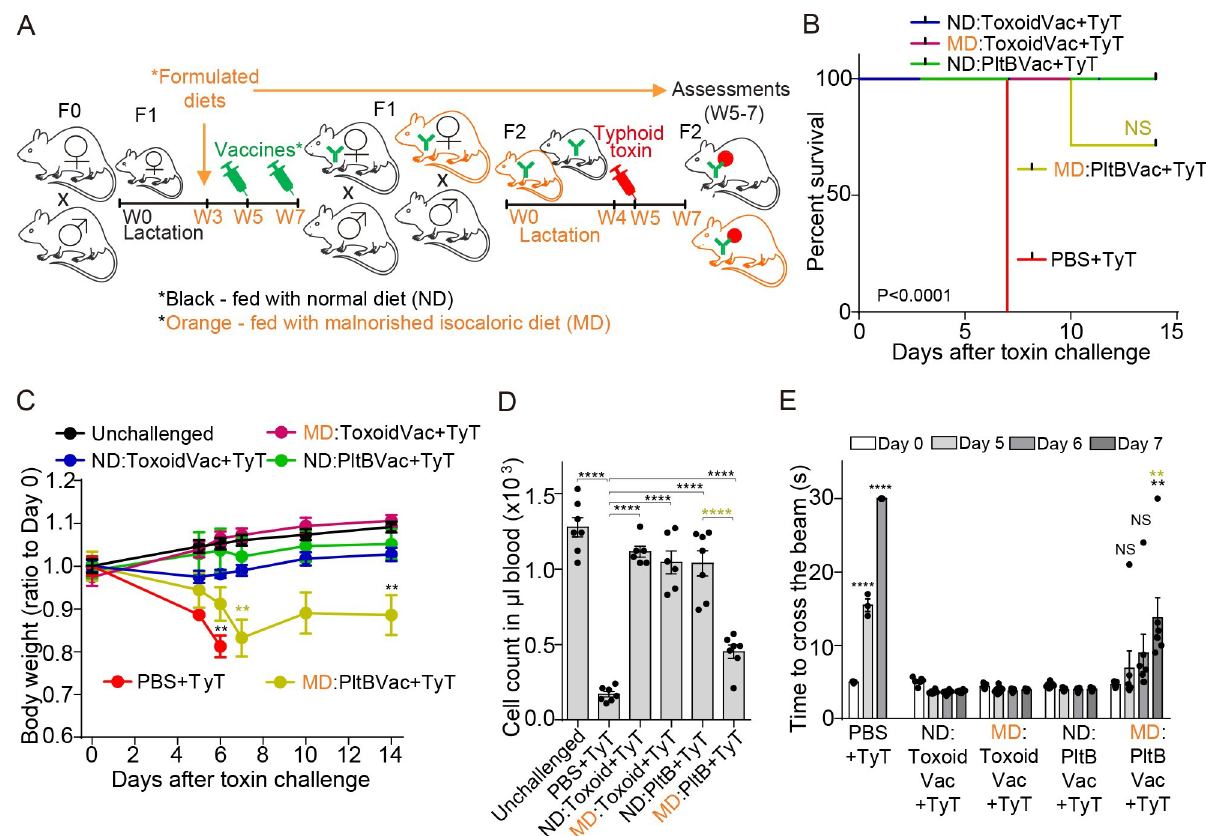
Fig 3. Maternal antibodies protected some but not all progenies against typhoid toxin in malnutrition. A , Timelines of indicated diet-feeding, maternal vaccinations, toxin challenge, and assessments for protection. Both F1 and F2 mice were fed with indicated diets, which were started when F1 mice were 3 weeks old and continued throughout the experimental timeframe. B , Survival of the maternally-vaccinated F2 mice challenged with 2 μ g typhoid toxin (TyT). ND:ToxoidVac (blue), normal diet-fed F2 mice maternally vaccinated with ToxoidVac. MD:ToxoidVac (plum), malnourished diet-fed F2 mice maternally vaccinated with ToxoidVac. ND:PltBVac (green), normal diet-fed F2 mice maternally vaccinated with PltBVac. MD: PltBVac (olive), malnourished diet-fed F2 mice maternally vaccinated with PltBVac. C , Body weight changes of these F2 mice after receiving 2 μ g typhoid toxin for the 14 day-experimental period. D , Circulating neutrophil counts in peripheral blood of these F2 mice on day 6 after the toxin challenge. E , Balance beam walking results of these F2 mice on days 0, 5, 6, and 7 after the toxin challenge. Bars represent the mean ± SEM. n = 6–7 F2 mice per group. NS, not significant; �� , p < 0.01; ���� , p < 0.0001, relative to the unchallenged group for C, to the unchallenged group or the TyT group for D as indicated in the graph, and to the day 0 value for E. Green symbols are used to indicate the statistic analysis results between MD:PltB+TyT group and ND:PltB+TyT group in B-E. The log-rank test was performed for B and two-tailed unpaired t-tests for C, D, and E. neutralizing antibody titers in F1 mothers (Fig 5E), and maternal antibody transfer from F1 to F2 progenies (Fig 5F), indicating that the decreased maternal antibody transfer from F1 to F2